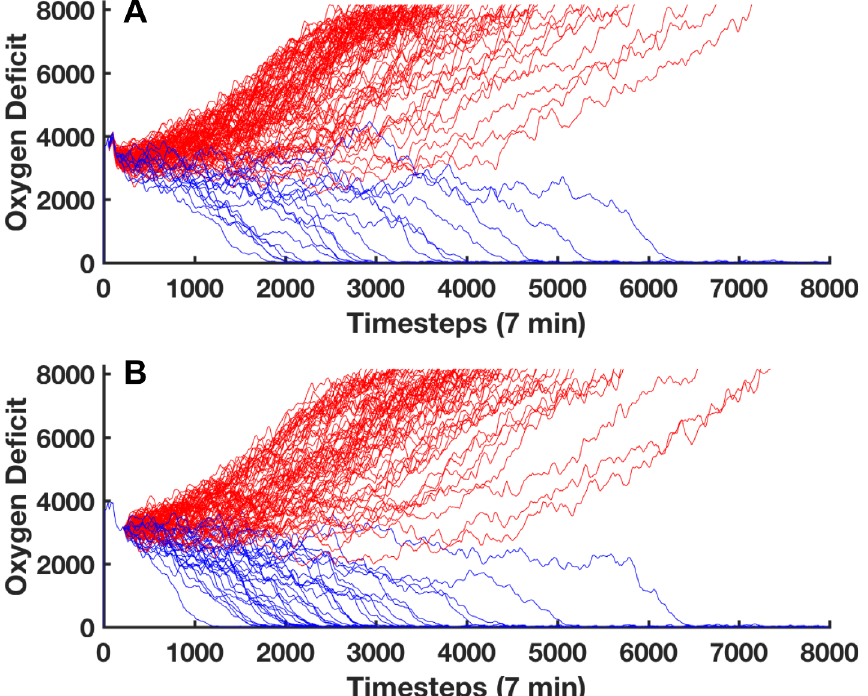
Fig 6. Stochastic trajectory example. Panel A displays 100 stochastic trajectories generated by the IIRABM for a specific parameter set (Invasiveness = 2; Host Resilience = 0.1; Toxigenesis = 5; Environmental Toxicity = 2) with an injury with a radius of 33 cells. The total systemic oxygen deficit, an inverse measure of the in silico patient’s health (y- axis) is presented as a function of time (x-axis). 82% of the simulated patients (red) end in death, while 18% heal completely (blue). The trajectories shown in panel B use the same parameter set as in panel A, however the run is started with a specific random number generator seed; the random number generator is re-seeded at 12 hrs post injury. At 1-day post injury, this specific patient has a 68% chance of